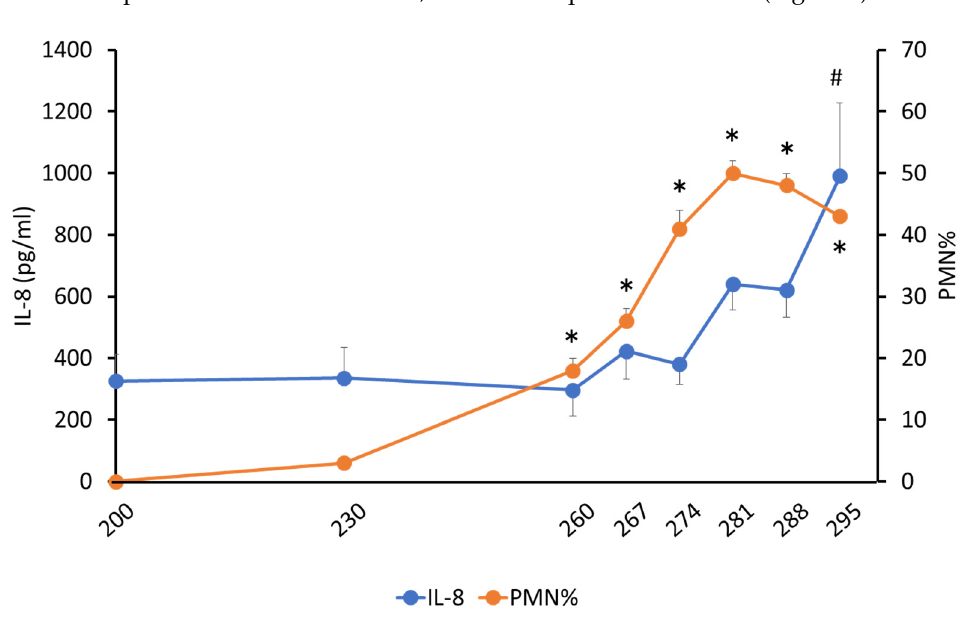
Figure 3. Interleukin-8 and polymorphonuclear neutrophil % in bovine cervical mucus with weeks to calving. # p < 0.05 compared with w-13 to -12 in PMN%. 3.1.2. Determination of Total Protein and Cytokine Concentrations Protein concentrations in the cervical mucus showed an increasing trend ( p = 0.08). The IL-8 concentration in the cervical mucus was significantly different at 295 days (990.5 ± 236.9 pg/mL) versus 200 (326.3 ± 85.2 pg/mL), 230 (335.8 ± 98.5 pg/mL) and 260 (296.1 ± 84.6 pg/mL) days of pregnancy (Figure 2). IL-8 increased from w-13 to -12 (333.3 ± 94.0 pg/mL) to w-2 (650.9 ± 145.8